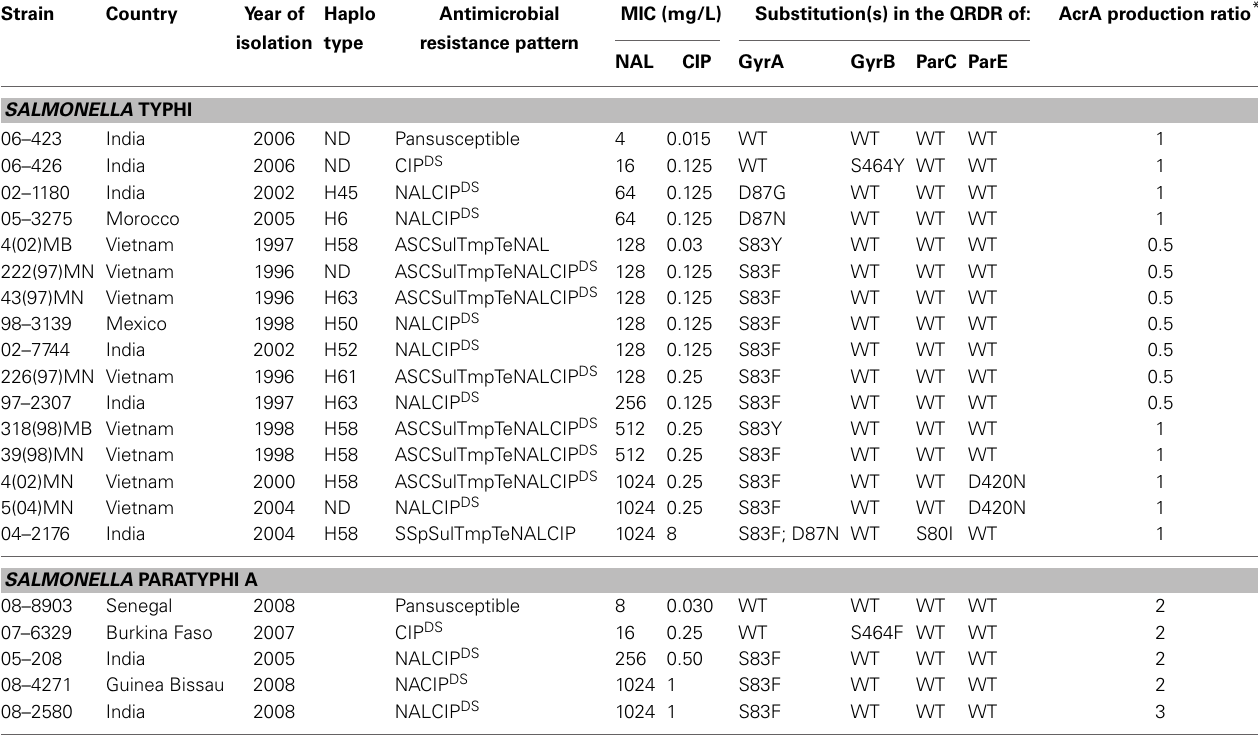
Table 1 | Salmonella enterica serovars Typhi and Paratyphi A strains analyzed in this study. Strain Country Year of Haplo